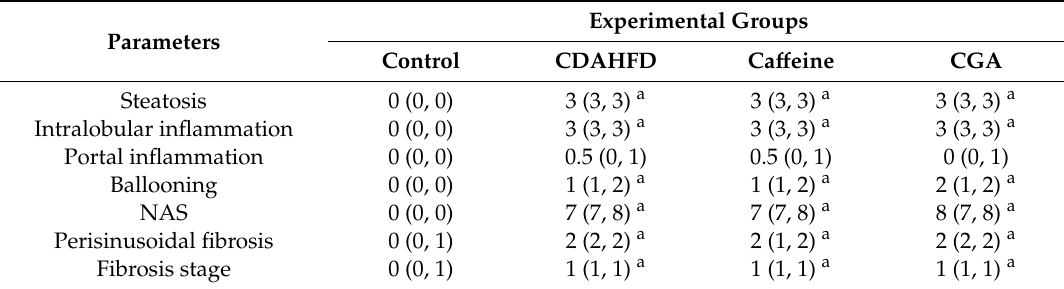
Table 4. Histopathological findings of experimental